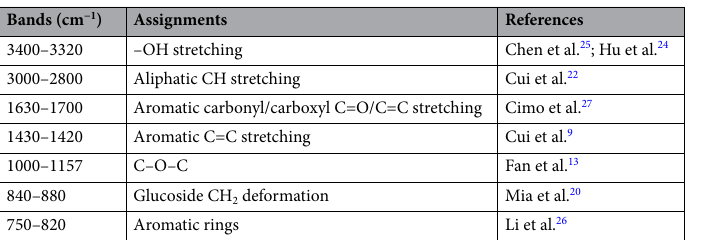
Table 2. Band assignments in FTIR spectra of